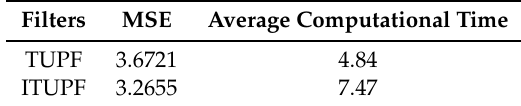
Table 3. Mean square error (MSE) and computational time of the ITUPF and TUPF.